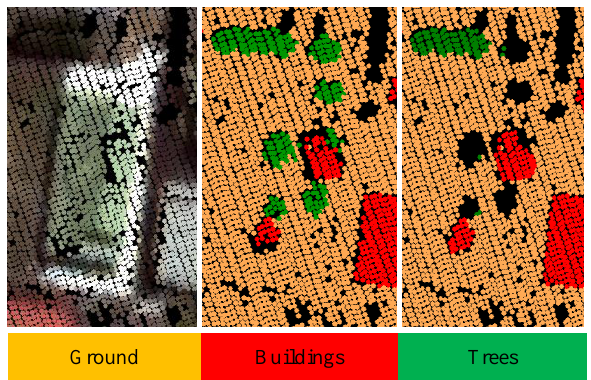
Figure 7. Colourised LiDAR points (left), classified LiDAR points using LiDAR data only (middle) and fused LiDAR data and NDVI (right).